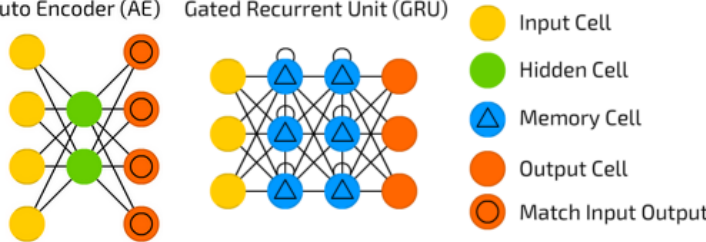
Figure 1. A visualisation of a classic autoencoder ( left ) and recurrent neural network consisting of gated recurrent units (GRUs) ( right ) [24]. These two methodologies are what we combined to create an autoencoder (AE) capable of utilising